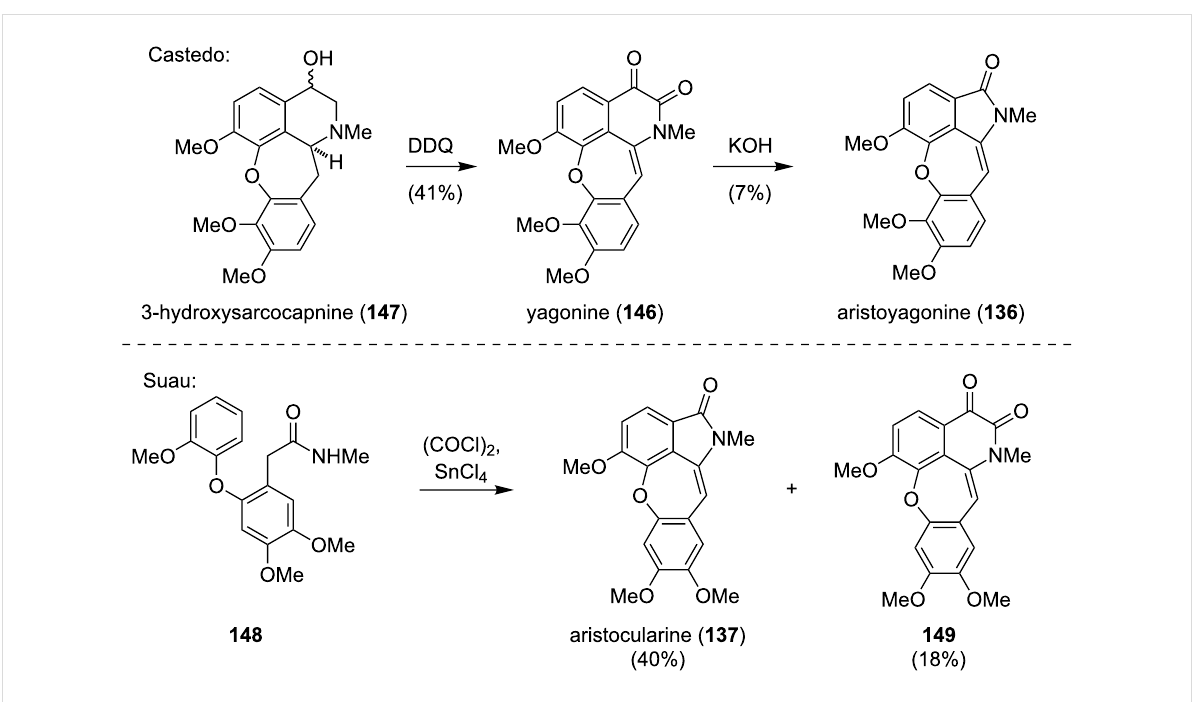
Scheme 19: The syntheses of 136 and 137 reported by Castedo and